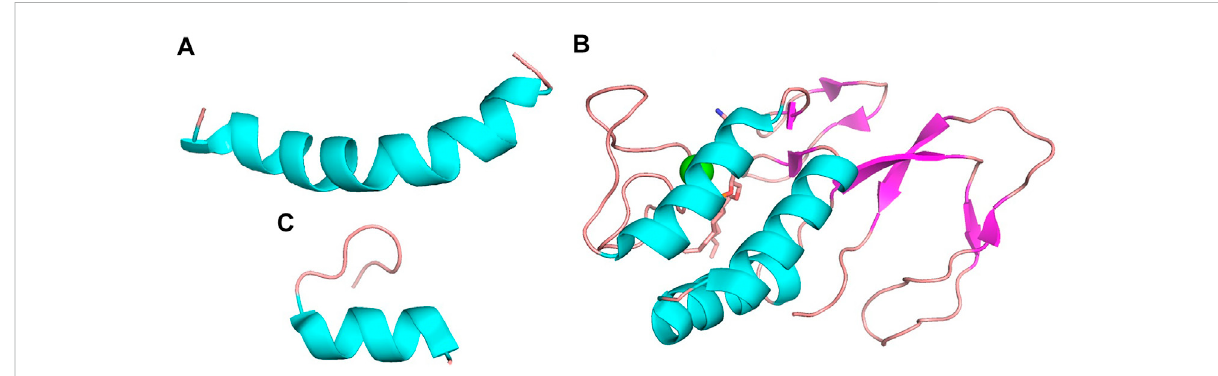
FIGURE 1 Thestructures of (A) MEL(PDBID6dst), (B) bvPLA 2 (PDBID1poc)and (C) apamin(PDBID7oxf).Structure (A) and (C) appeartobedominatedby α -helix while structure (B) is dominated by a combination of α -helix and β -pleated